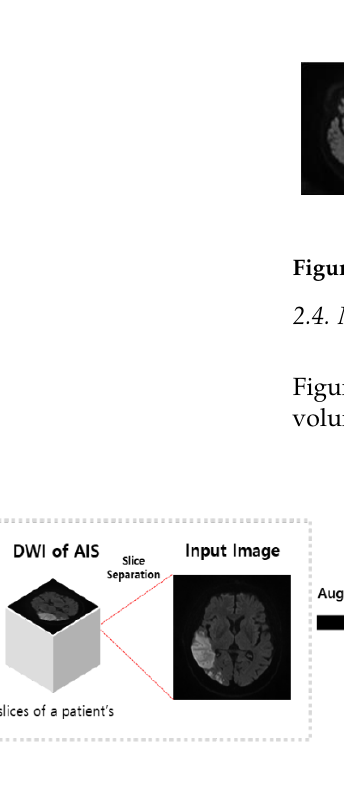
Figure 1. Example of ( a ) large-sized AIS on DWI and ( b ) small-sized AIS on DWI .